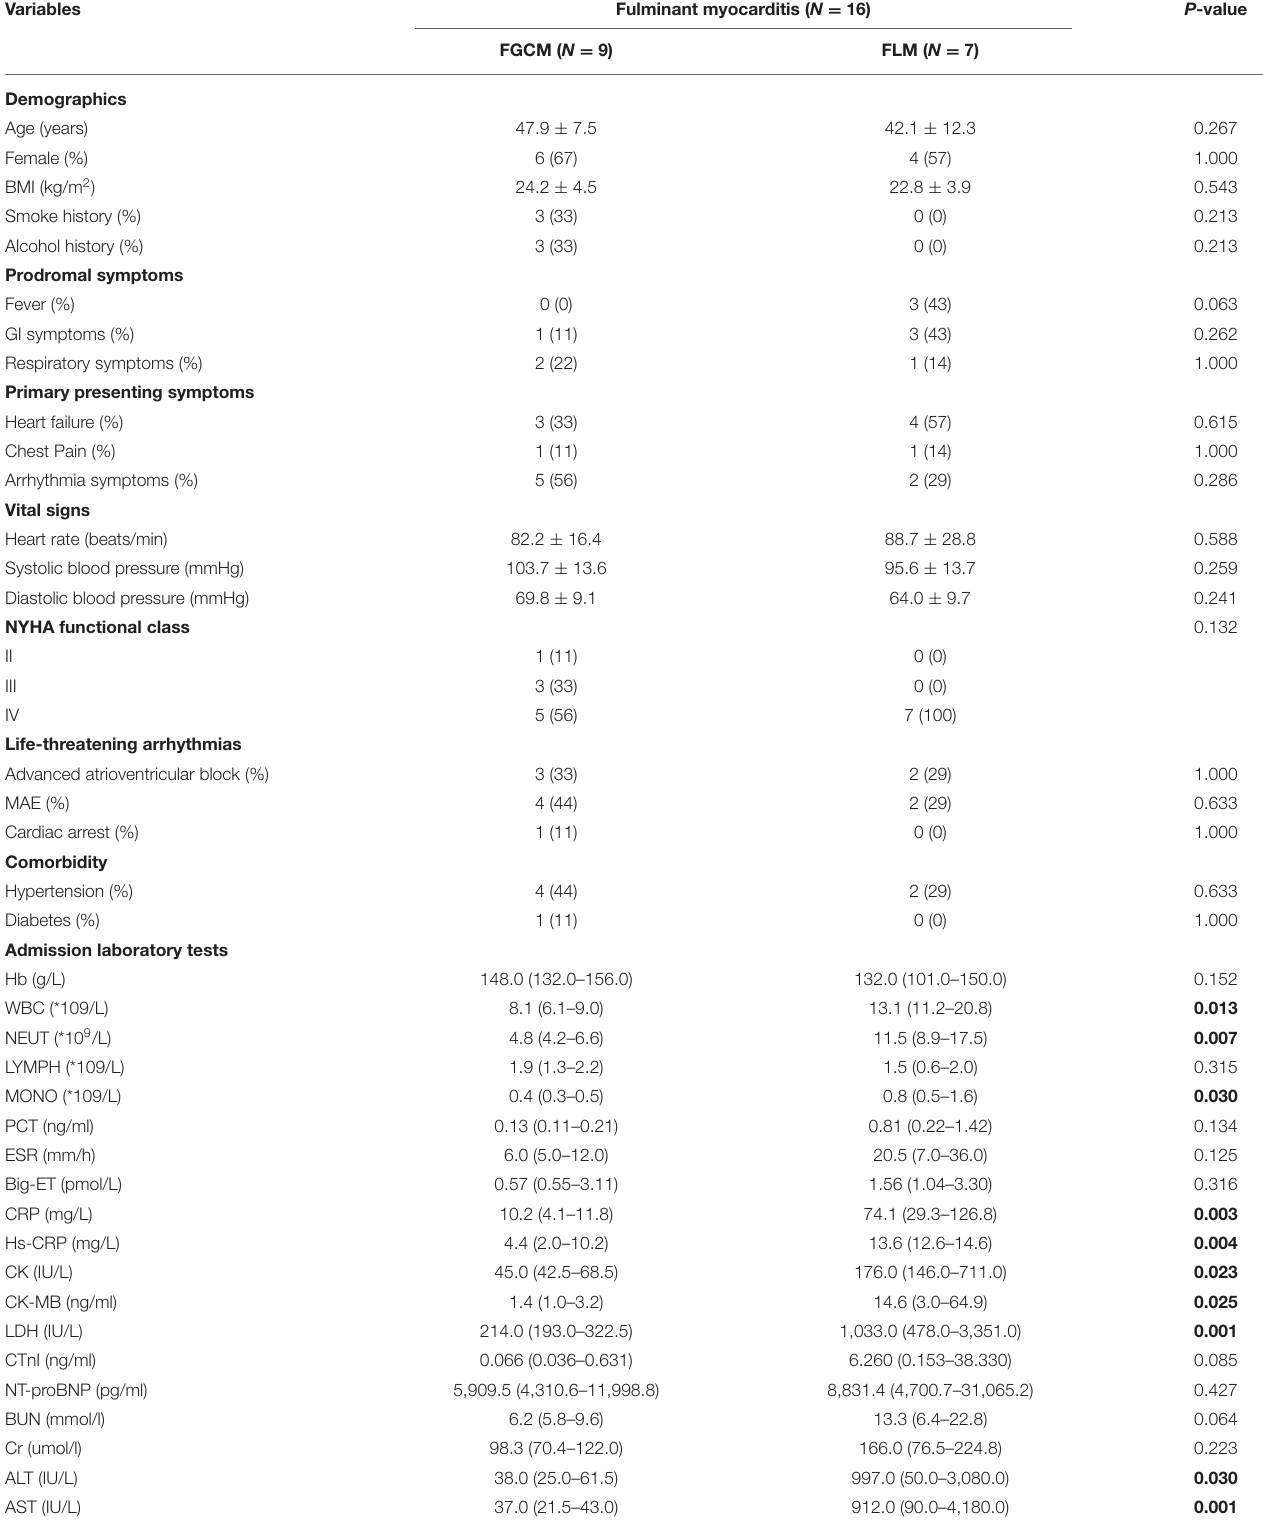
TABLE 1 | Comparison of baseline characteristics, clinical presentation, laboratory examinations, and echocardiography findings in patients with FGCM and